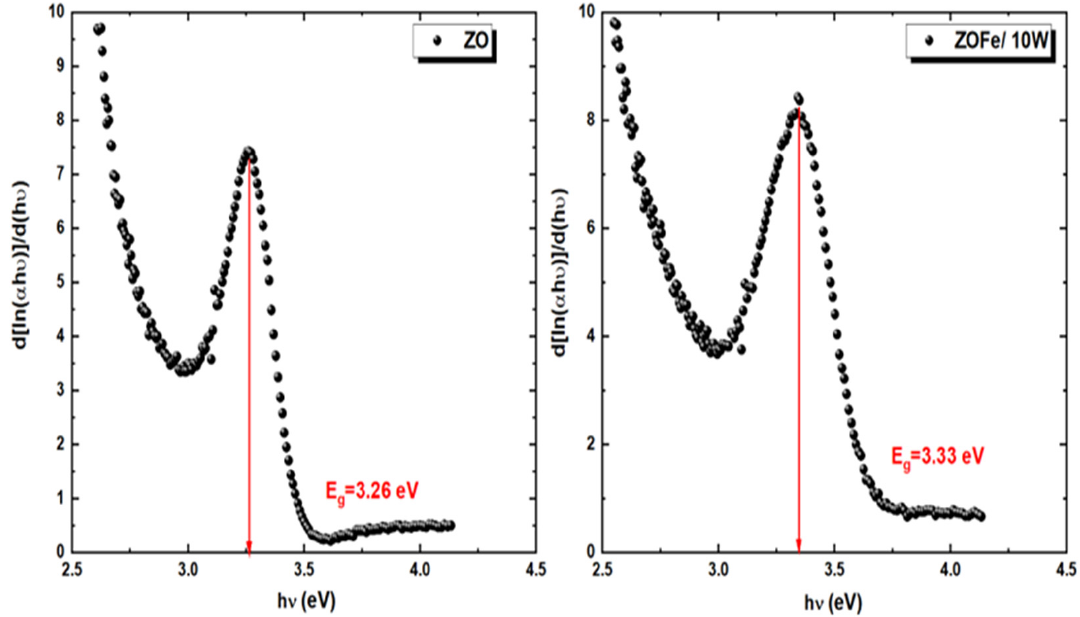
Figure 11. LD of α h ν as a function of photon energy h ν with fitted straight lines for the undoped and Fe/10 w doped ZO thin films.